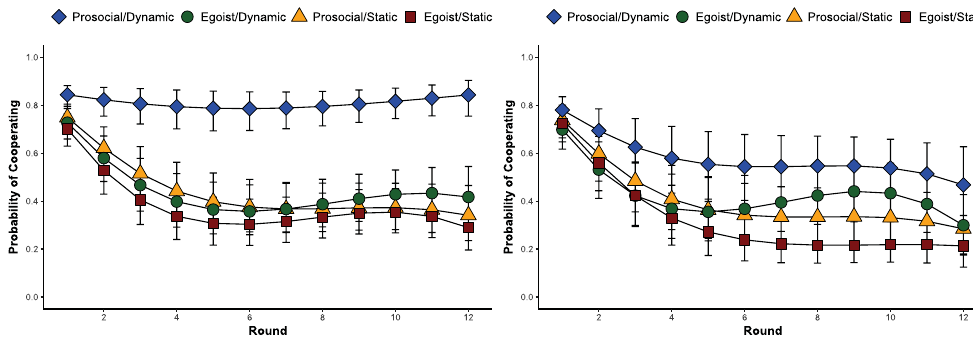
Figure 1. Marginal probability of cooperation with each alter in ( A ) homogeneous and ( B ) heterogeneous networks. Error bars refer to 95% confidence intervals around the marginal